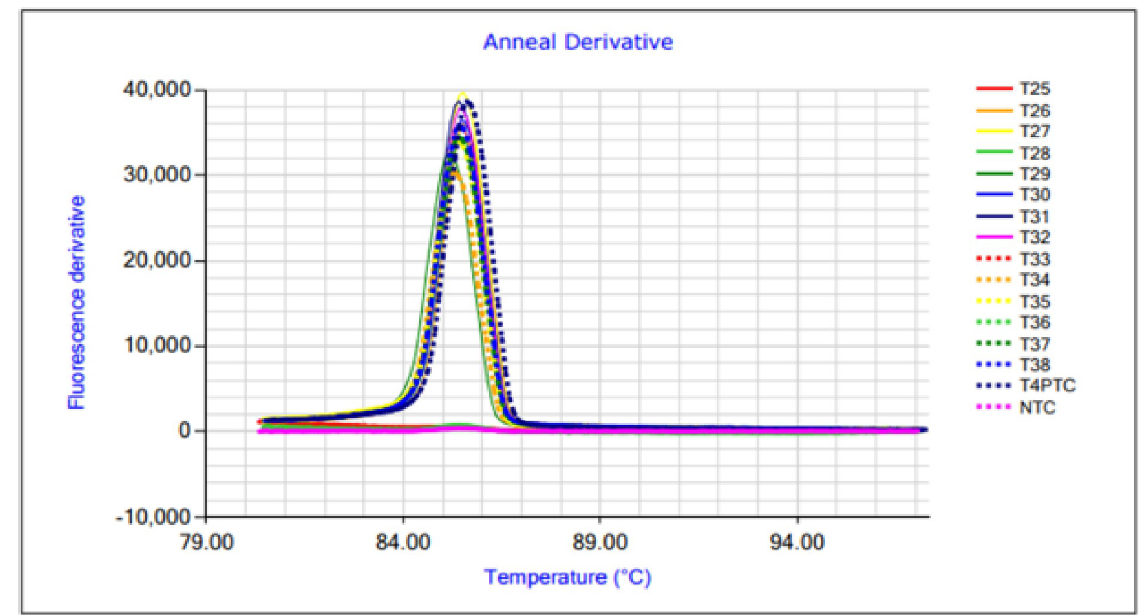
Fig 1. Melting curves of LAMP products from various Thunnus albacares DNA samples. The assay showed specific melting temperatures of 85.4 ± 0.8˚C. T4PTC = positive control; NTC = non-template control.